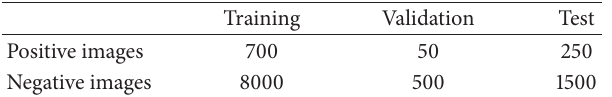
Table 1: Training, test, and validation set for breast